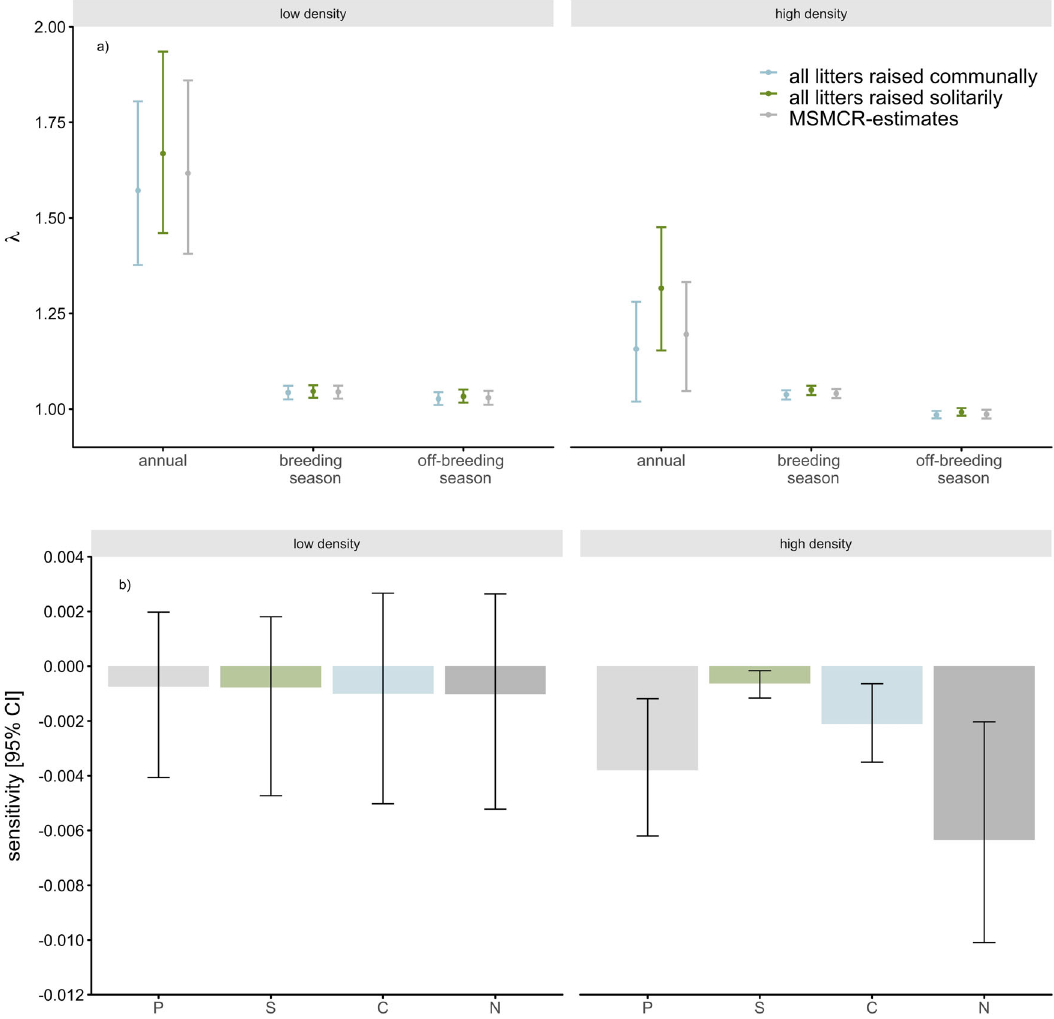
Fig. 3 Matrix population models. a Population growth rates ( λ , [95% CI]) are plotted for season- and density-speci fi c matrix population models that were parameterised with the estimates from the MSCMR-models in grey. In blue and green, λ estimates from matrix models with the same survival and breeding values are shown, but the probability to breed communally is fi xed to 1 (blue) or 0 (green), simulating populations with females using only one of the two tactics. b Sensitivities [95% CI] for the probability to breed solitarily during the breeding season at two different population densities. The Matrix population models were again parameterised with the estimates from the MSCMR-model (see Table S3,